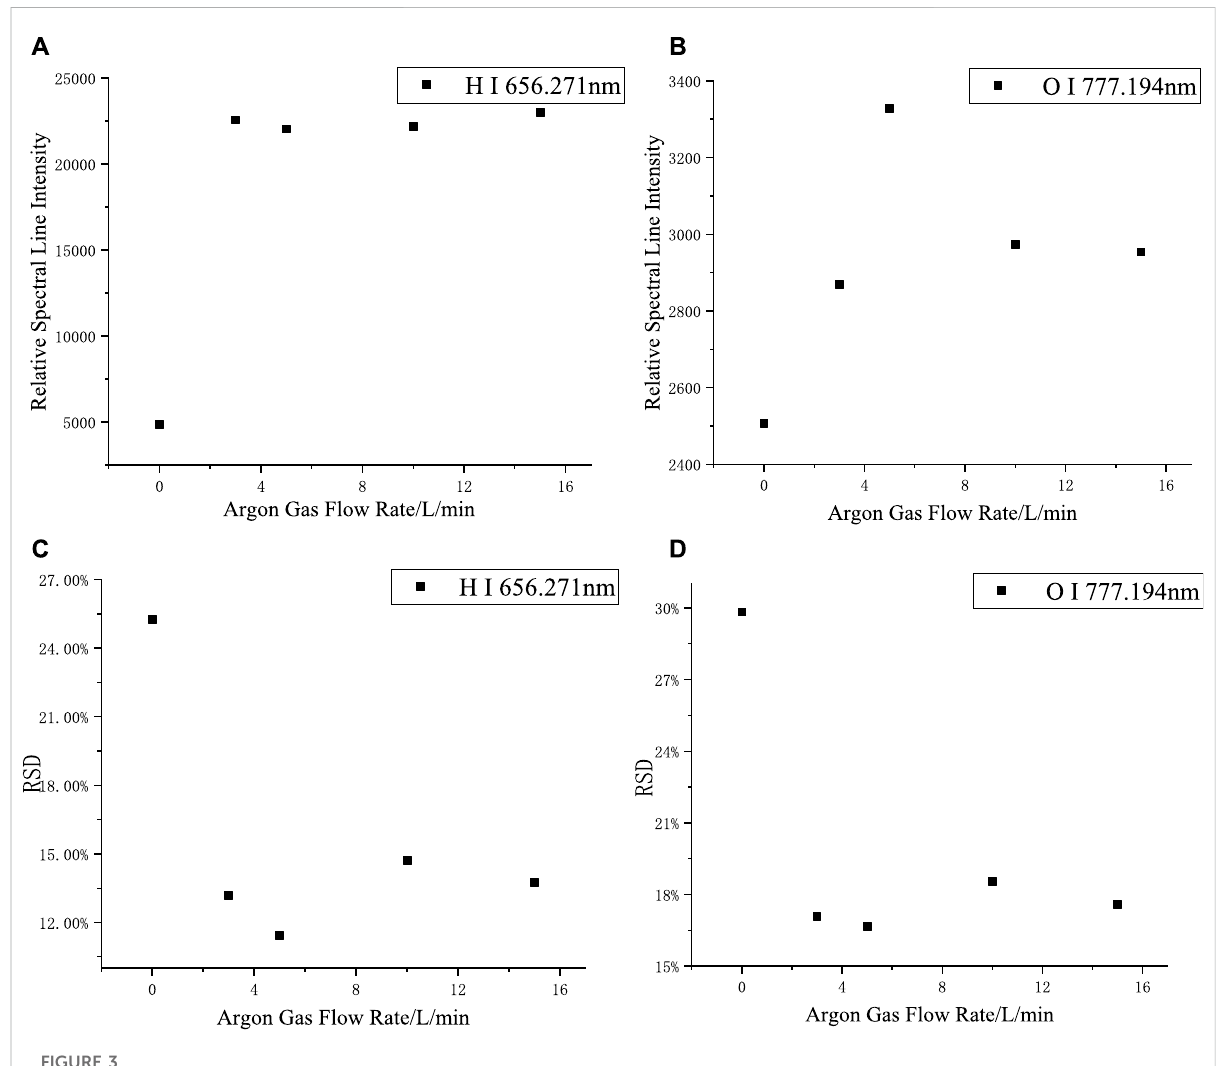
FIGURE 3 Changes of relative spectral line intensity and RSD with Argon fl ow rate: (A) H I 656.271 nm, (B) O I 777.194 nm, (C) O I 656.271 nm, (D) O I 777.194